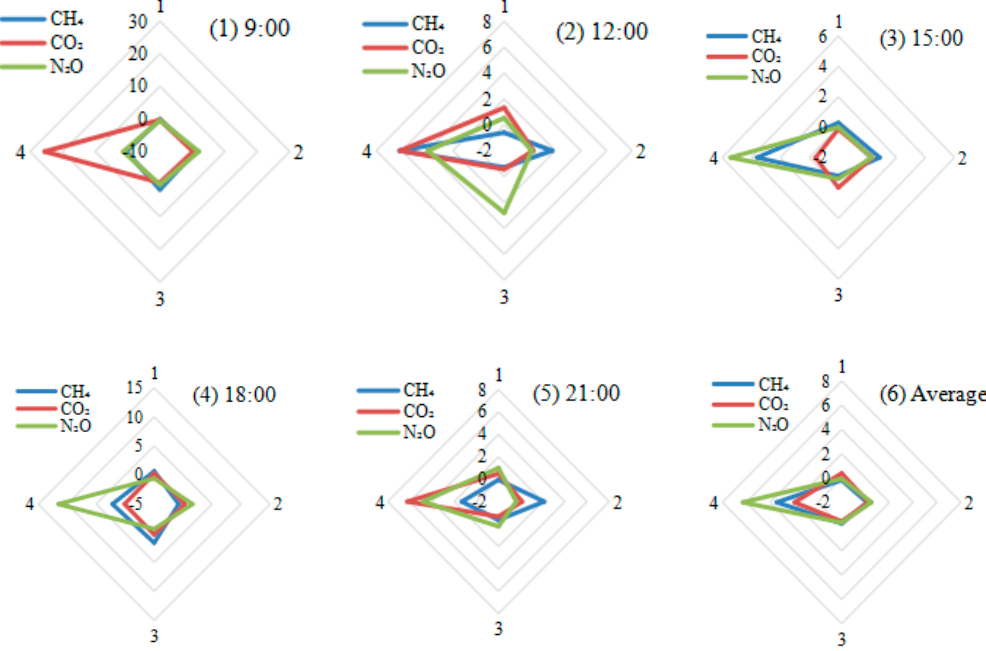
Figure 4. Amplification coe ffi cient (ACs) of GHGs emission flux at four dams in the Huoshaogou